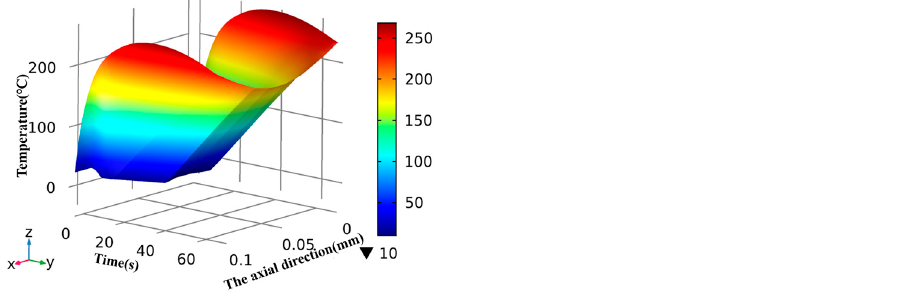
Figure 12. Three-dimensional time-temperature cloud along the axial direction of the ventilated brake disc gap brake disc gap structure.